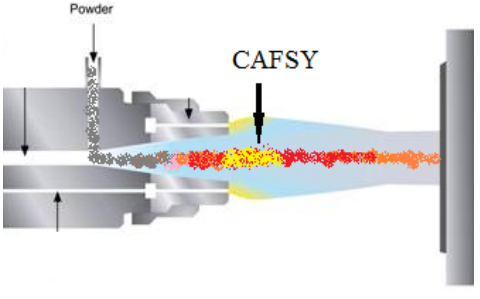
Figure 1. Scheme of combustion-assisted flame spraying (CAFSY) process.